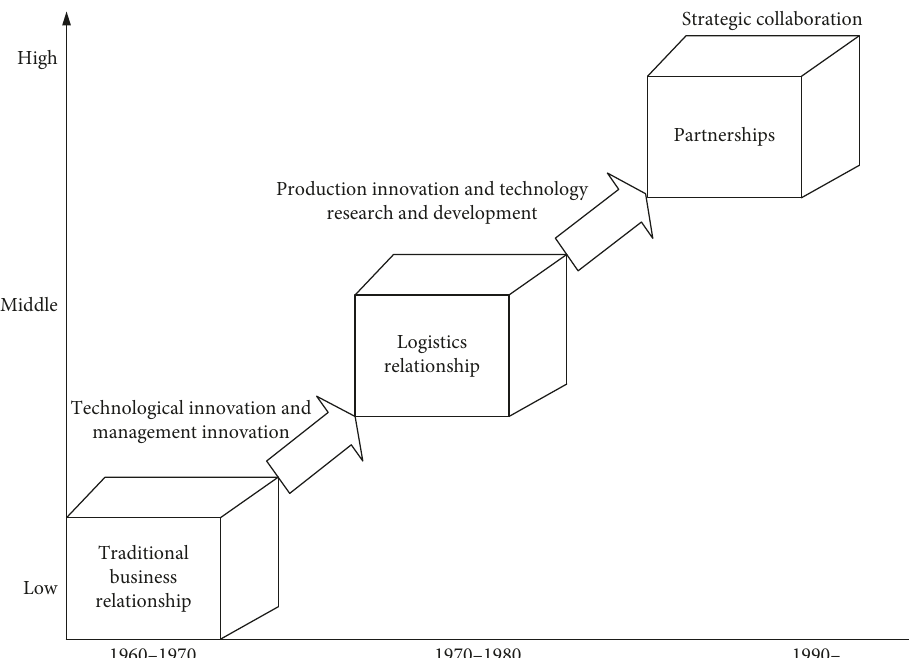
Figure 1: The history of supply chain and partnership